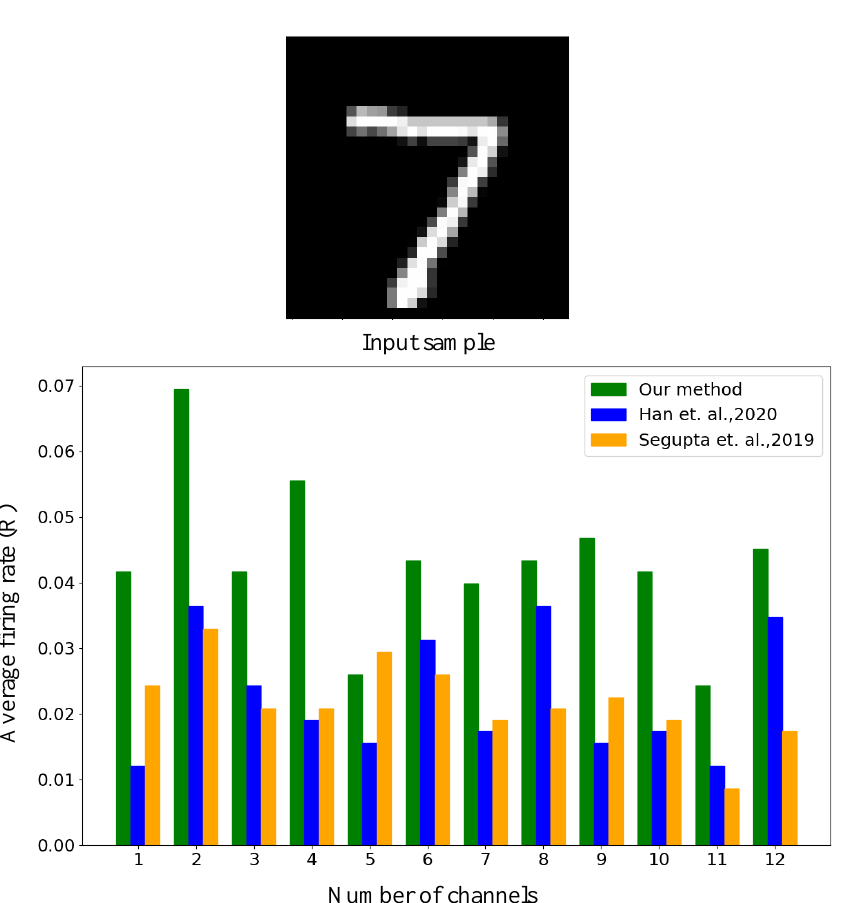
Figure 7. Average firing rates for the first convolutional layer of the SNN for the MNIST dataset